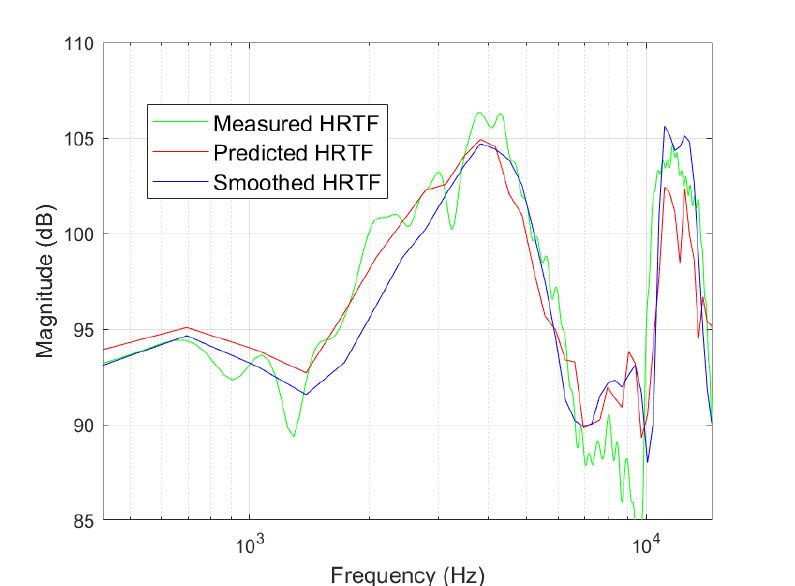
Figure 11. Magnitude comparison of measured, smoothed, and predicted at the frontal direction, where ( θ , φ ) = (0,0).